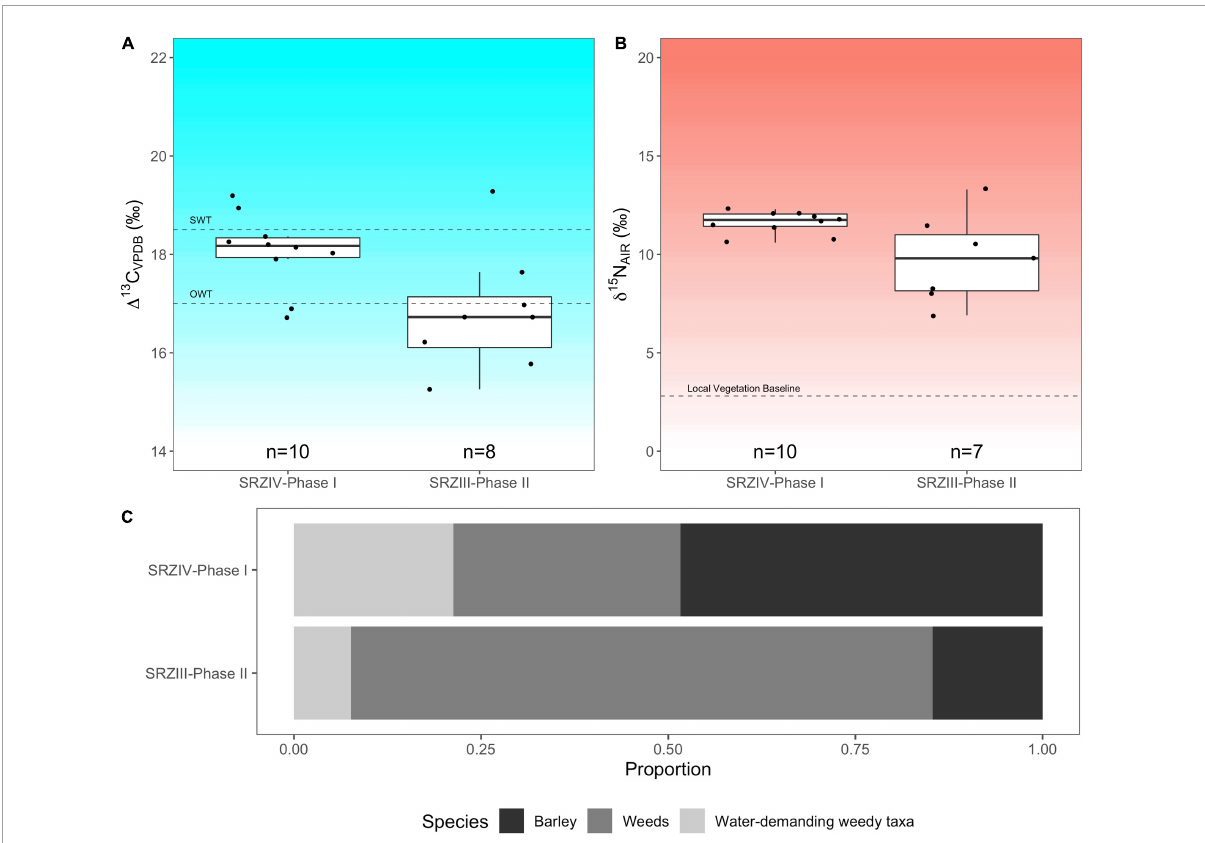
FIGURE5 (A) (cid:49) 13 C and (B) δ 15 N values of archaeological barley recovered from Shirenzigou IV of Phase I and Shirenzigou III of Phase II; (C) proportion of barley, arable weeds (excluding water-demanding weeds) and water-demanding weeds in the archaeobotanical assemblages of Shirenzigou IV (Phase I) and Shirenzigou III (Phase